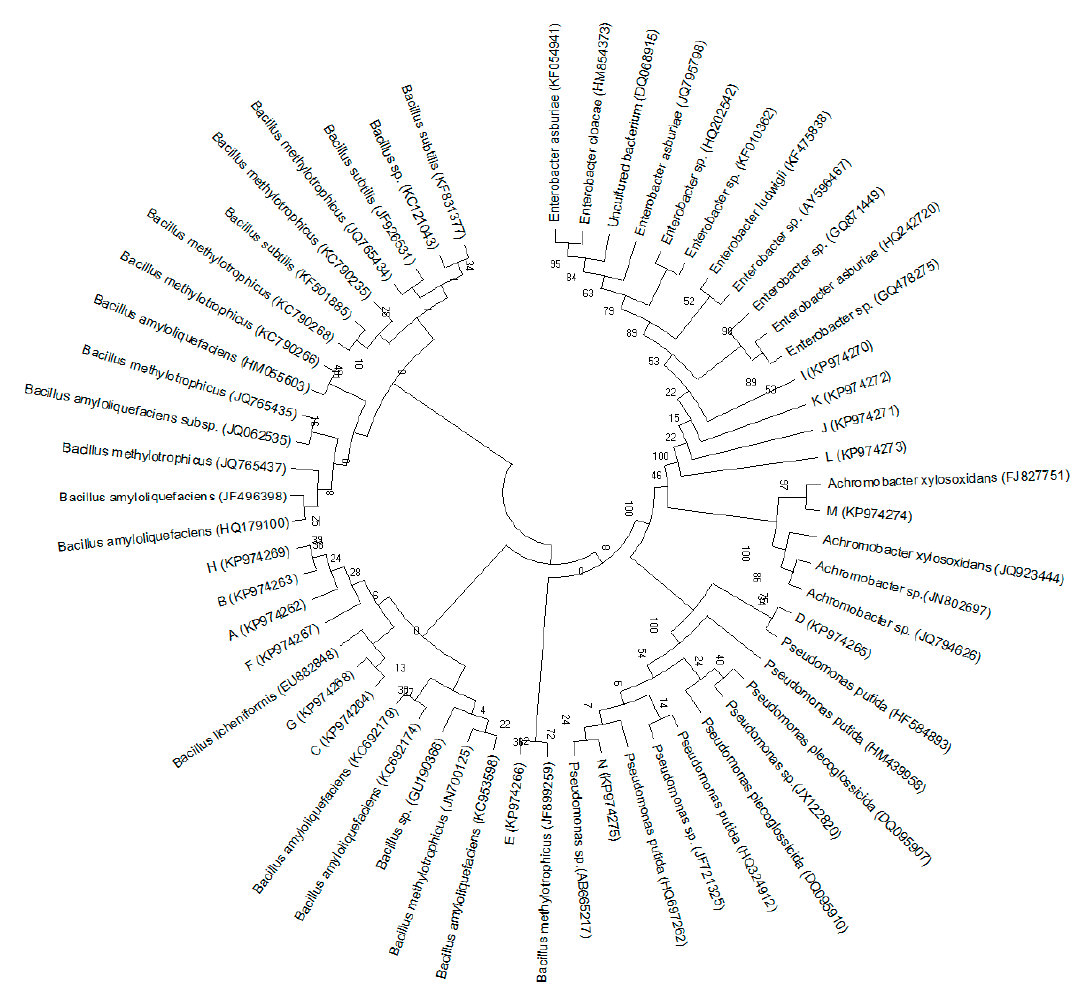
Figure 3. Phylogenetic trees based on the 16S rDNA sequencing, drawn by MEGA 6.06.